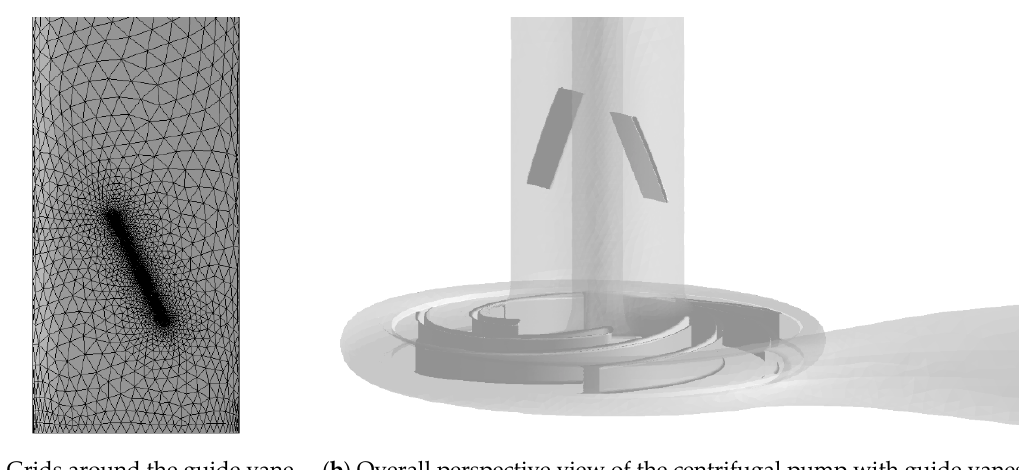
Figure 2. Schematic diagram of inlet guide vanes.